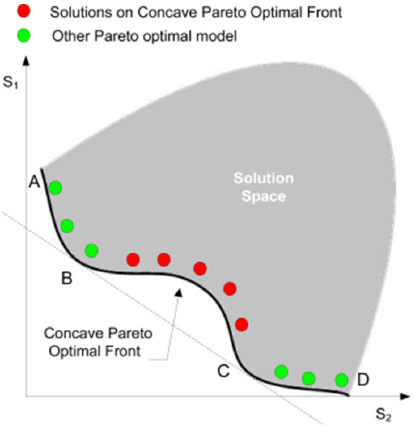
Fig. 1. An example of Pareto solutions on a non-convex Pareto